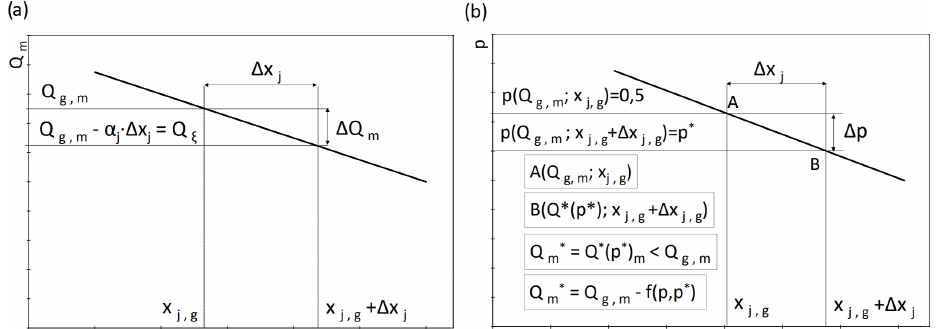
Figure 3. Calculation diagram showing the effect of changes in the x j , g value by (cid:49)x j on (a) the flow volume Q m and (b) probability of exceeding p(Q g , m ; x j , g ) =